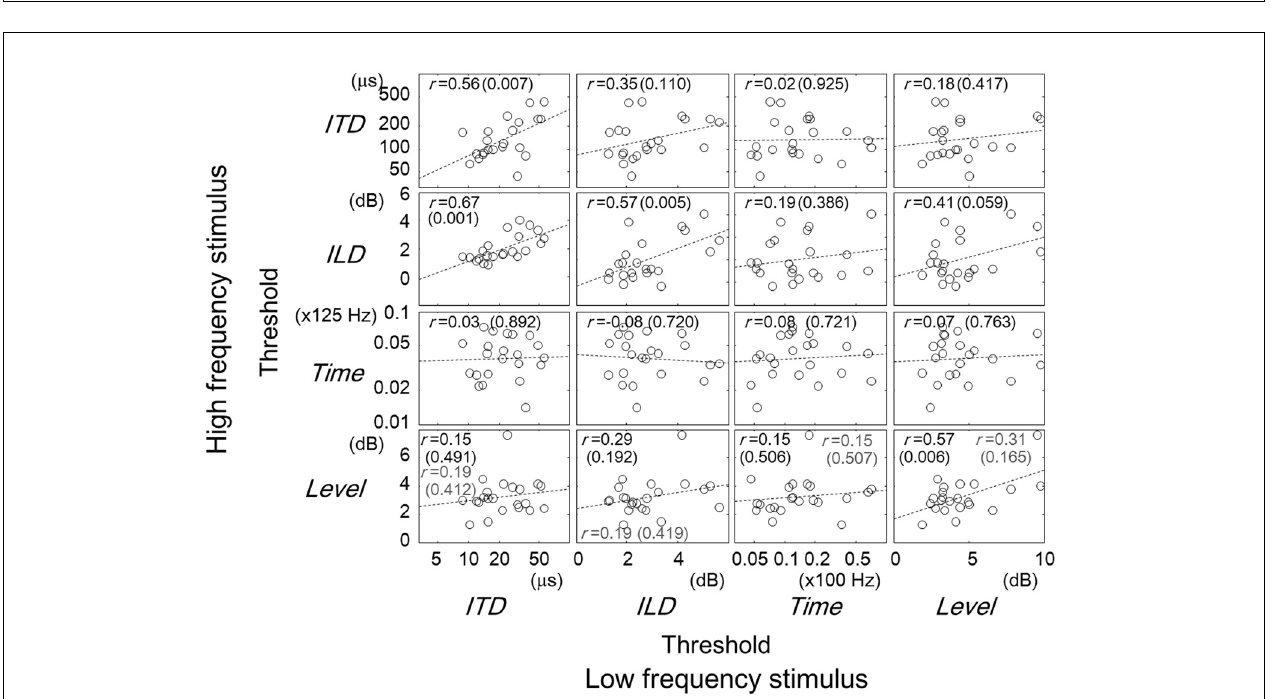
FIGURE 4 | Comparisons of thresholds between tasks for different frequency regions. The panels are arranged so that the horizontal and vertical axes represent the data for the low- and high- frequency stimuli, respectively. Other conventions are the same as in Figures 2 , 3 .